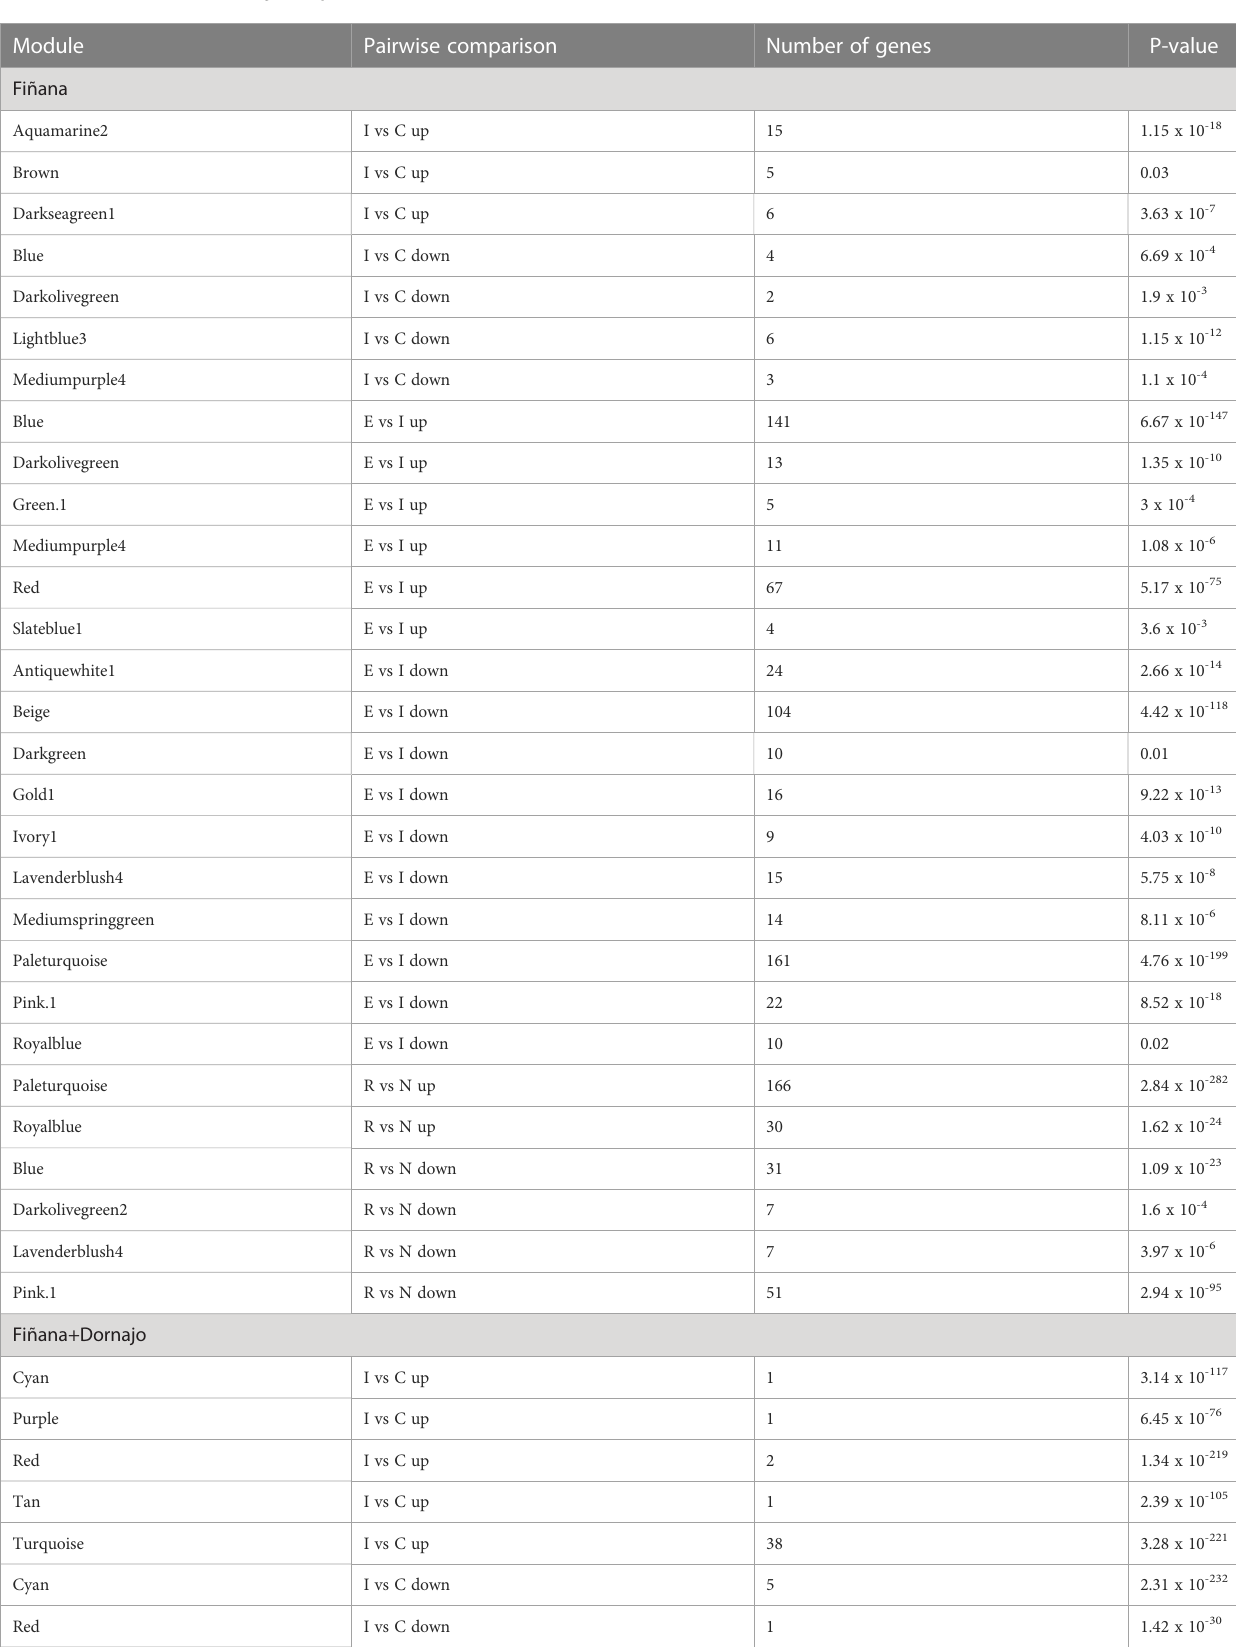
TABLE 2 Results of the enrichment analysis between pairwise DE up and down regulated genes and the 194 obtained modules in Fiñana samples, and the 15 modules in Fiñana+Dornajo samples.